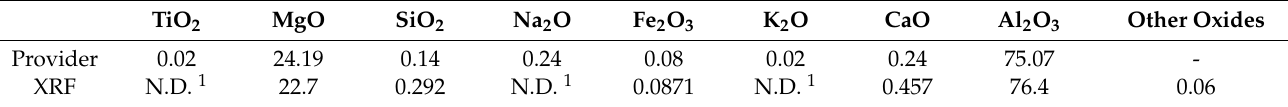
Table 1. Chemical composition of the MgAl 2 O 4 powder